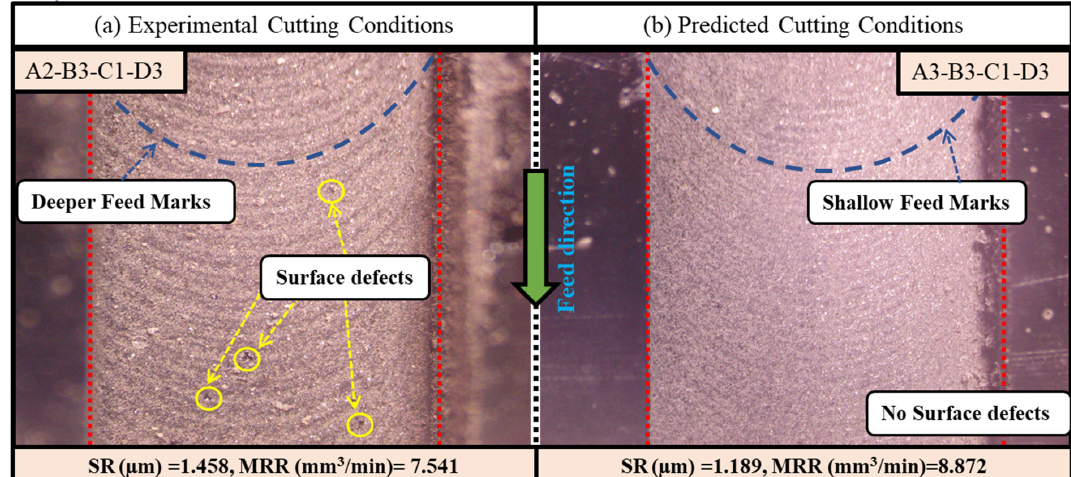
Fig. 13. Microscopic view of the Milling slot (machined